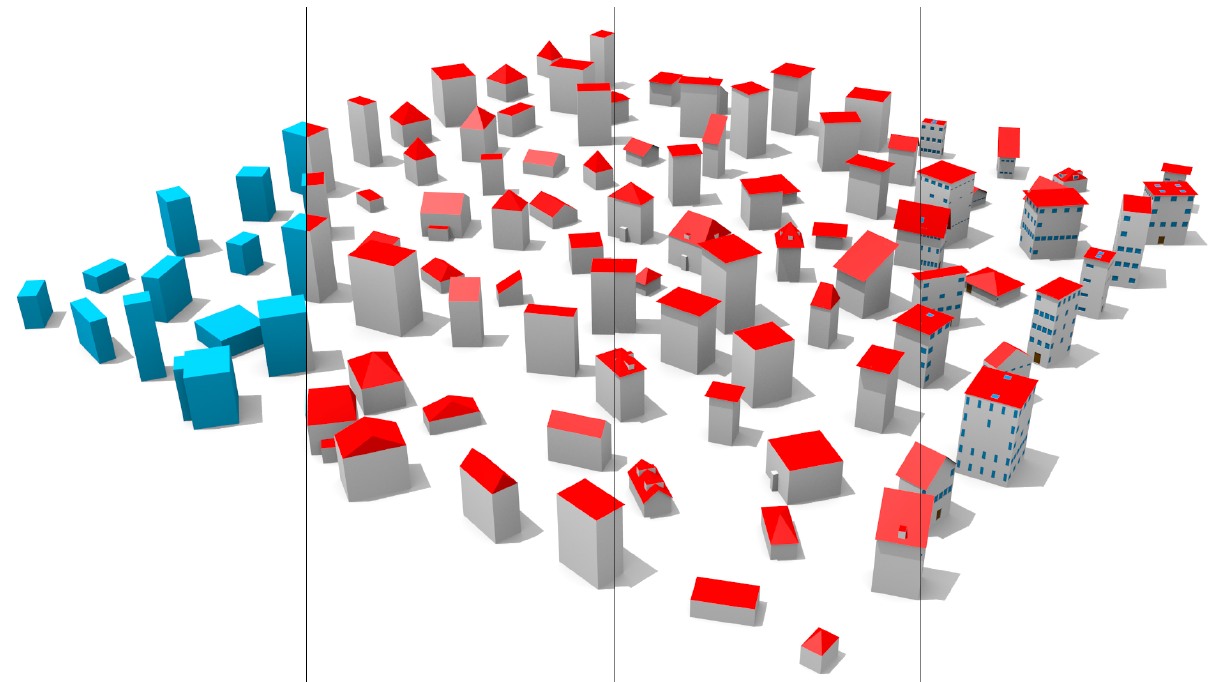
Figure 4: Composite rendering of a few exemplary datasets generated by R ANDOM 3D CITY : randomly generated buildings realised in CityGML in four LODs. The two representations on the left have their walls modelled as projections from roof edges as opposed to the third panel where the walls are modelled at their actual location and where roof overhangs are explicitly modelled, showing varying geometric references that are supported by the engine, besides multiple geometric and semantic LODs. Figure 6: Example of the building parameters stored in an